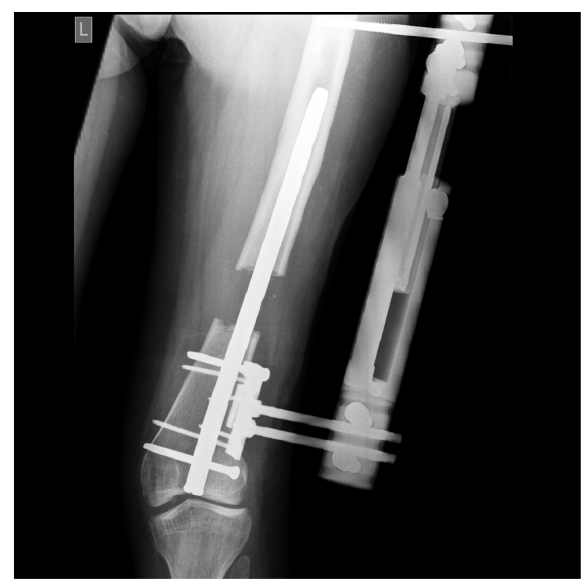
Figure 5. Radiograph of the distal femur in the patient from Figure 4 after the acute phase of lengthening has been completed.